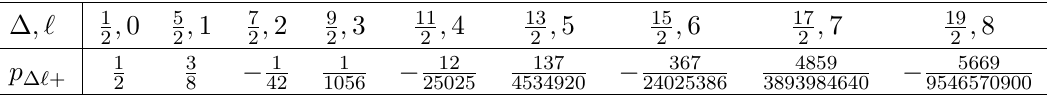
Table 4 . OPE coefficients for parity even operators in the conformal block decomposition of JφJ ¯ φ and φJJ ¯ φ .